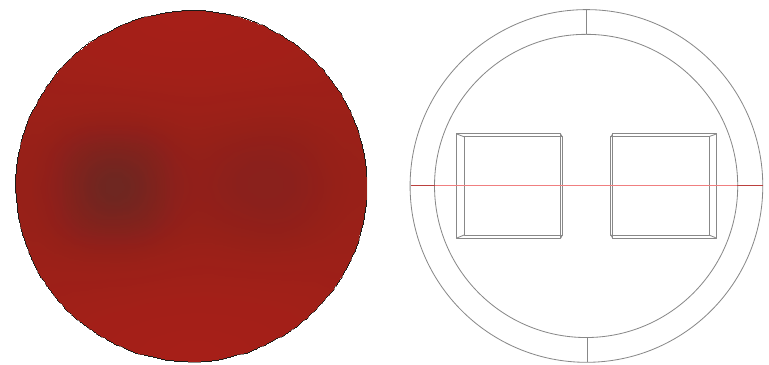
Figure 8: Line that is used to plot a temperature related graph of the surface of specimen.